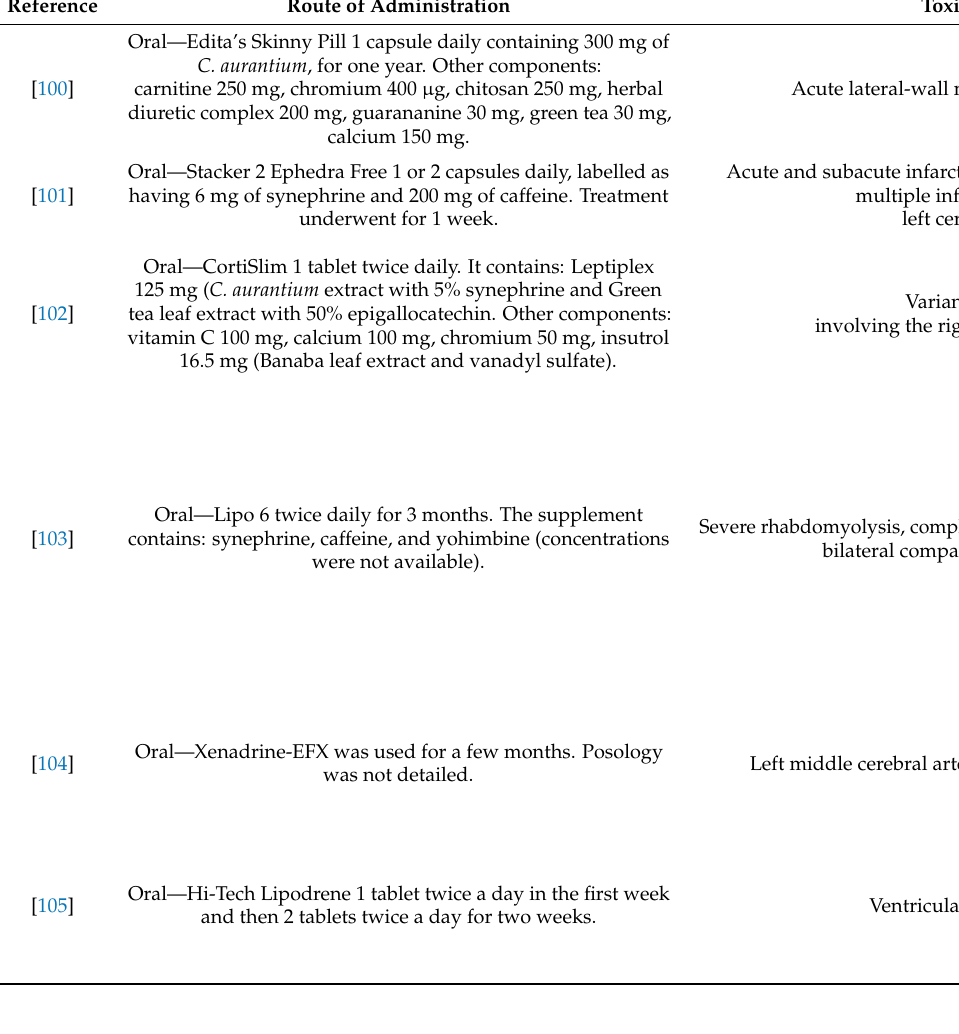
Table 3. Synephrine and C. aurantium related toxicity case reports in